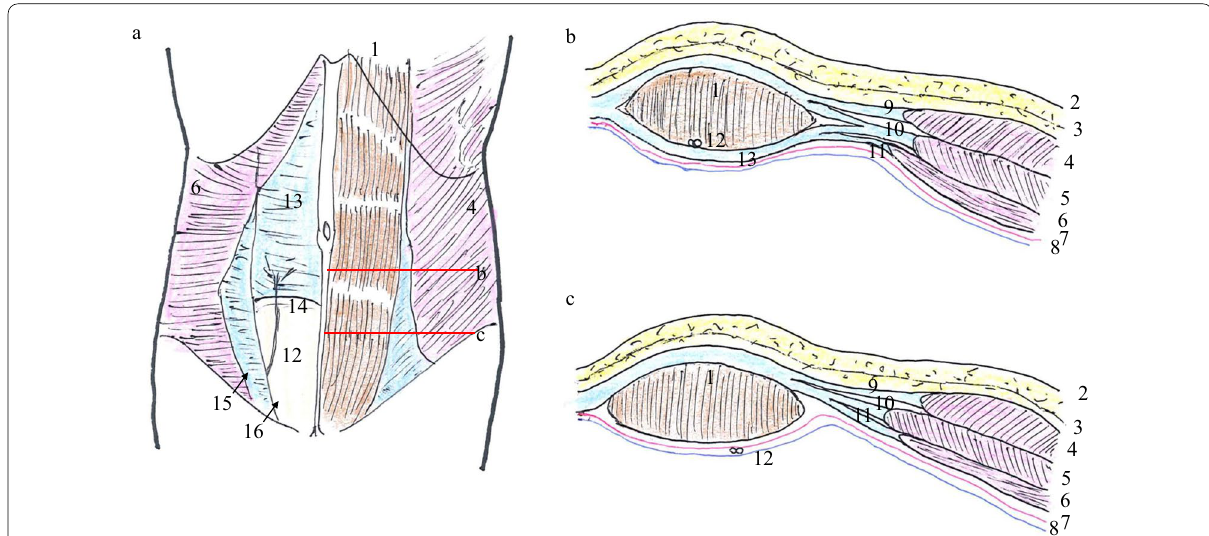
Fig. 1 Diagram of the anterior abdominal wall. a The right rectus abdominis muscle, external oblique muscle, and internal oblique muscle were resected. b Section above the arcuate line. c Section below the arcuate line. 1 Rectus abdominis muscle, 2 skin, 3 Scarpa’s fascia, 4 external oblique muscle, 5 internal oblique muscle, 6 transverse abdominis muscle, 7 transversalis fascia, 8 peritoneum, 9 aponeurosis of the external oblique muscle, 10 aponeurosis of the internal oblique muscle, 11 aponeurosis of the transverse abdominis muscle, 12 inferior epigastric vessels, 13 posterior layer of the rectus abdominis, 14 arcuate line, 15 semilunar line